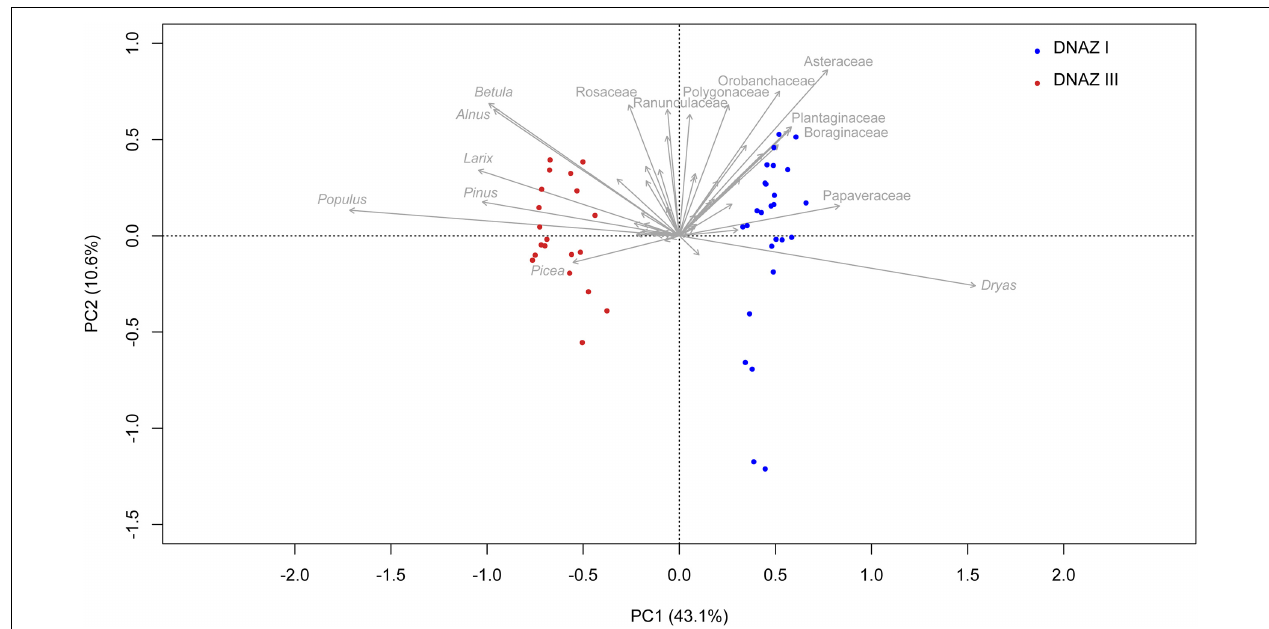
FIGURE 7 | Principal component analysis (PCA) biplot of sedaDNA terrestrial taxa. Only the names of the 15 taxa explaining the most variance are printed. Samples are colored according to their corresponding zone. The explained variances of the two principal components (PC1 and PC2) are shown in brackets.